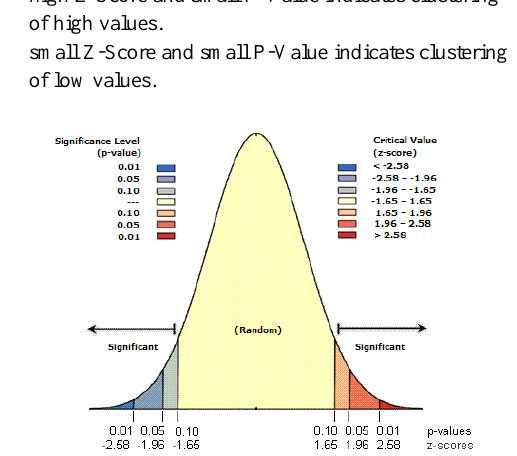
Figure 6. Different states of P-value and Z-Score (Mitchell,